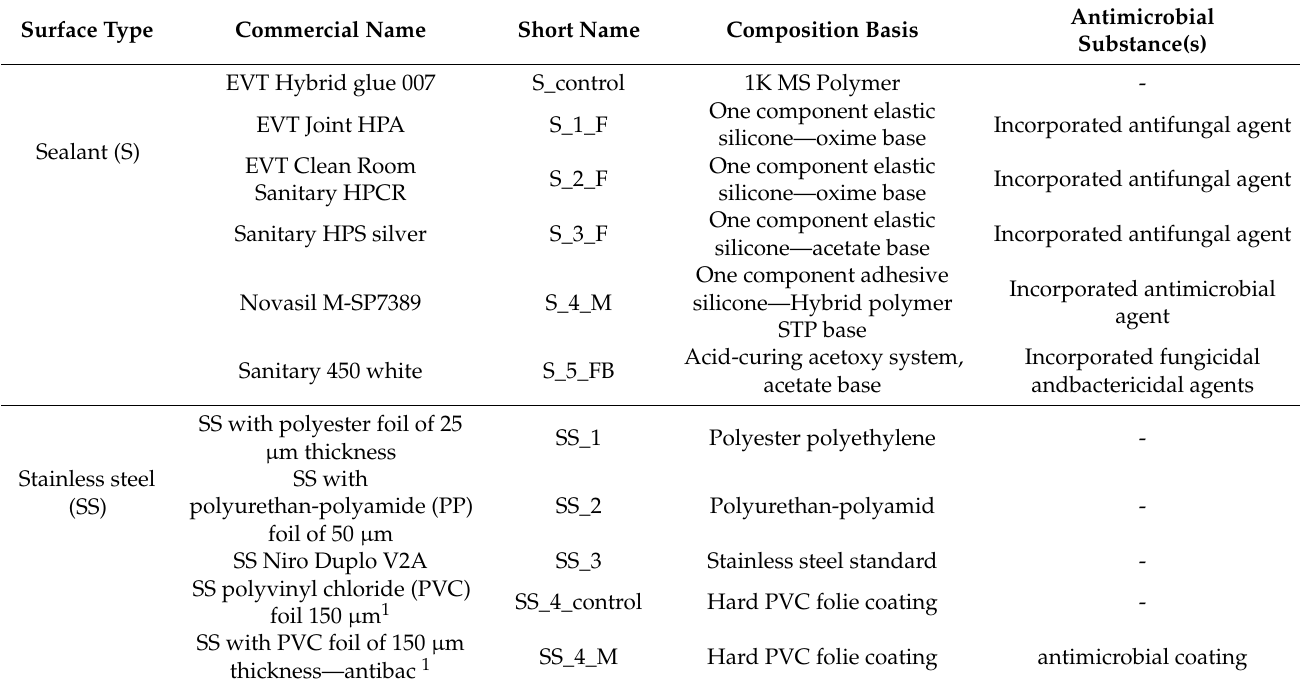
Table 1. Detailed information about the tested sealant and stainless steel surfaces with or without antimicrobial, -fungal or/and bactericidal components according to the manufacturer’s data; The different antimicrobial surfaces are marked as followed: F—antifungal, M—antimicrobial, FB— fungicidal and bactericidal. 1 Same surface type with and without antimicrobial